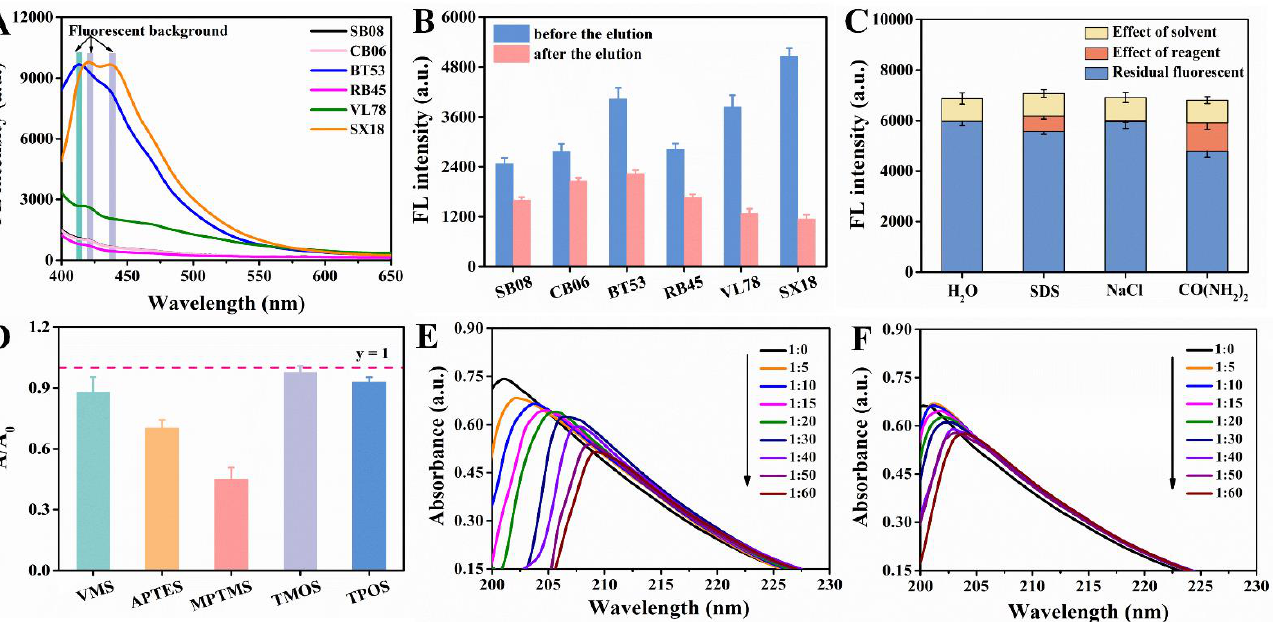
Figure 3. ( A ) Background fluorescence spectra of six different unprocessed papers (SB08, CB06, BT53, RB45, VL78, SX18). ( B ) Fluorescence intensity changes of six different papers grafted with CdSe QDs before and after elution. ( C ) Possible binding mechanism between CB06 and CdSe QDs. ( D ) Absorbance intensity changes of dimethoate before and after reaction with different kinds of silanization reagents (the molar ratio of dimethoate to silanization reagent was 1:100). The absorption spectra of dimethoate treated with different concentrations (molar ratio) of MPTMS ( E ) and APTES ( F ).